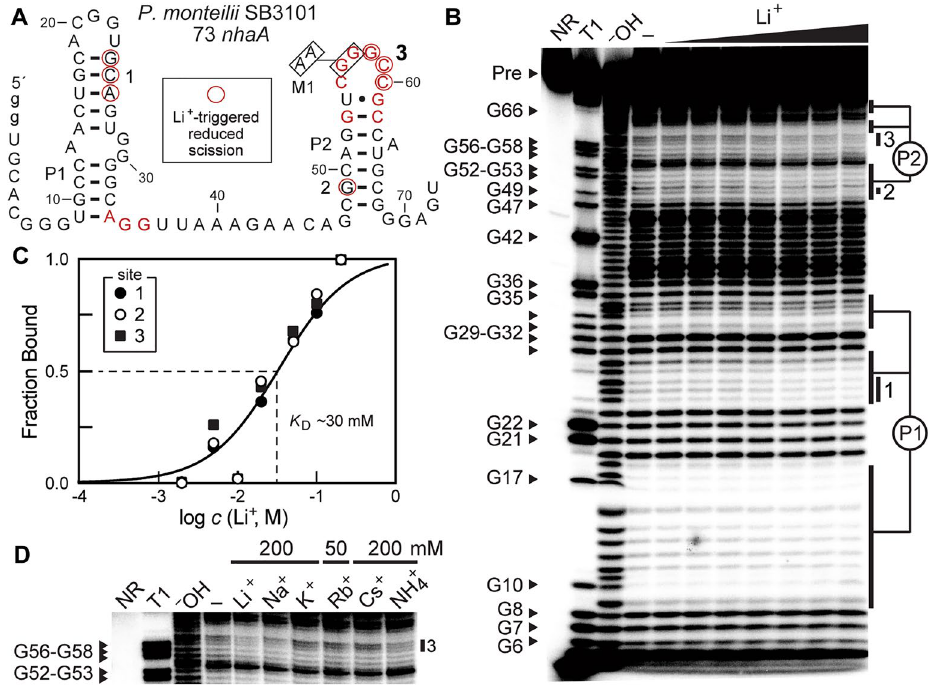
Figure 4. Li + induces structural modulation of a Li + -I aptamer. ( A ) Sequence and secondary structure model for the Li + -I riboswitch aptamer construct 73 nhaA derived from the nhaA gene from P. monteilii . Lowercase g letters identify non-native nucleotides added to facilitate production by in vitro transcription and red nucleotides are highly conserved in nhaA -I motif RNAs as depicted in Fig. 1A. Boxed nucleotides at positions 56 and 57 were mutated to A nucleotides in construct M1. Nucleotides circled in red are among those that undergo reduced spontaneous cleavage during in-line probing assays upon the addition of Li + , as determined from the autoradiogram depicted in B. ( B ) PAGE analysis of in-line probing reactions with 5 ′ 32 P-labeled 73 nhaA RNA in the absence of Li + (–), or in the presence of Li + concentrations ranging from 2 to 200 mM. NR, T1 and – OH identify RNAs subjected to no reaction, partial digestion with RNase T1 (cleaves after G nucleotides) and partial digestion with hydroxide (cleaves after each nucleotide). Bands corresponding to RNAs carrying a 3 ′ G nucleotide are identified according to the numbering system in A. A lower contrast version of the gel image is presented in Supplementary Fig. I in the Supplement. ( C ) Plot of the estimated fraction of RNAs bound to Li + versus the logarithm of the Li + concentration. Fraction bound values were estimated by quantifying band intensities at sites 1, 2 and 3 in B, which correspond to the nucleotides annotated with red circles in A. Note that fraction bound values were set to 1 at the maximum Li + concentration tested because the band intensities are near zero (maximal possible suppression). The solid line depicts a theoretical 1-to-1 binding curve with a K D of 30 mM. ( D ) PAGE analysis of in-line probing assays as described for B wherein reactions were supplemented with 200 mM of the ions indicated, except Rb + was tested at 50 mM. Reduced band intensities at site 3 depicted here are indicative of ion binding. A lower contrast version of the full gel image and comparisons of sites 1, 2 and 3 are presented in Supplementary Fig. IV in the